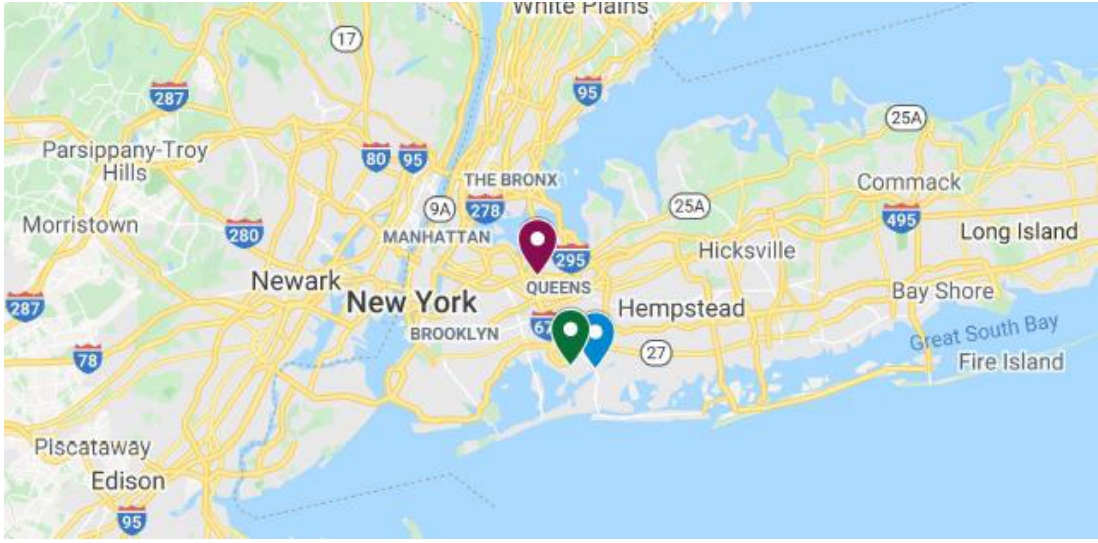
Figure 1. The study area and air and meteorological sampling sites in Queens county, New York. Red marker, Queens College; blue marker, Meadowmere Park; green marker, John F. Kennedy International Airport (original Google map has been personalized following Google guidelines, map